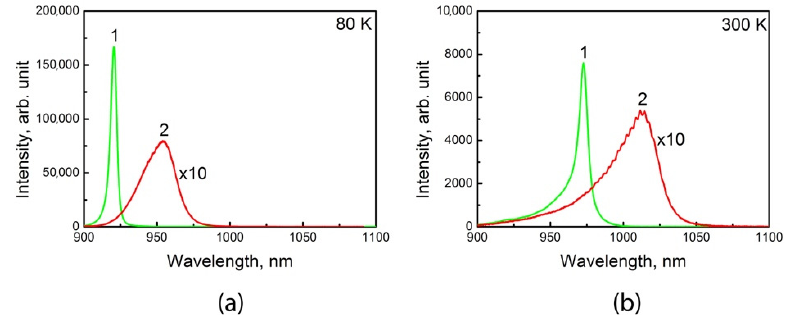
Figure 7. µ -PL spectra measured at 80 K ( a ) and 300 K ( b ) for St-ML (1) and SAE-ML-W (2) samples with InGaAs/GaAs QWs. For the SAE-ML-W sample, the spectra were taken at the window center.